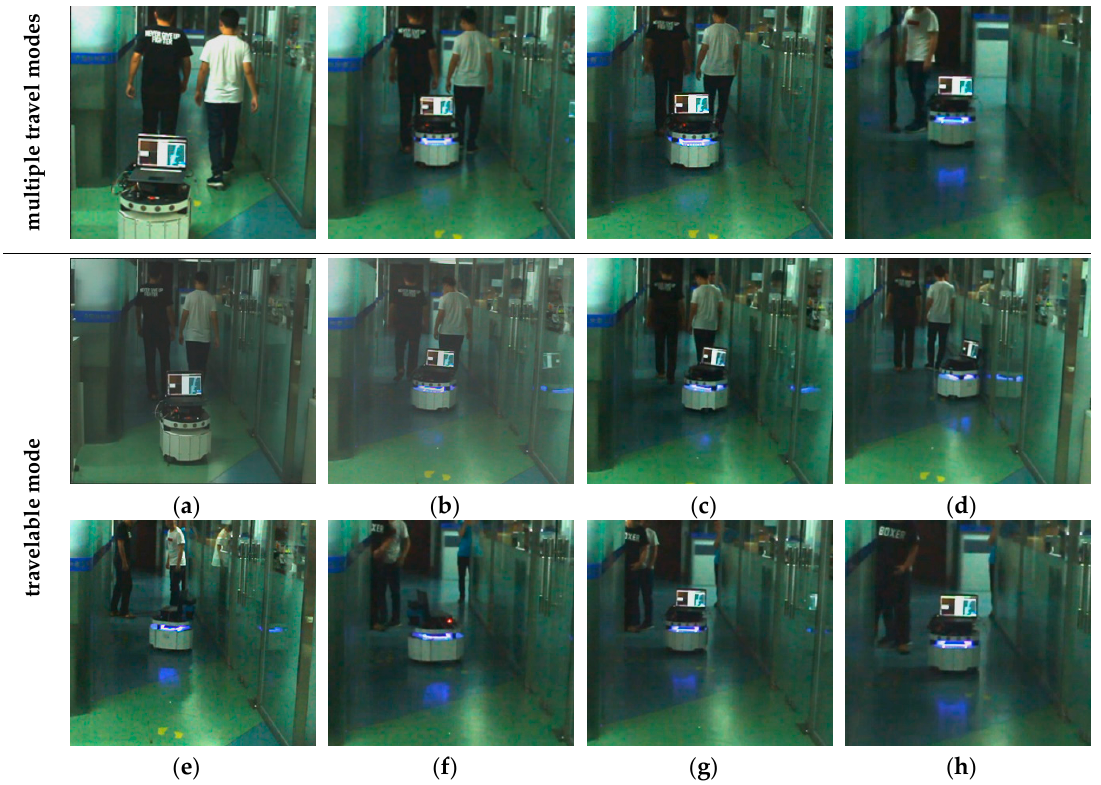
Figure 12. The robot’s navigation process with multiple travel modes and with the travelable mode only: ( a , b ) the robot explores trajectories randomly to detour the pedestrians ; ( c , d ) the robot collides with the wall; ( e , f , g ) the robot adjusts its trajectory again in the exploration process; ( h ) the robot reaches the goal position.